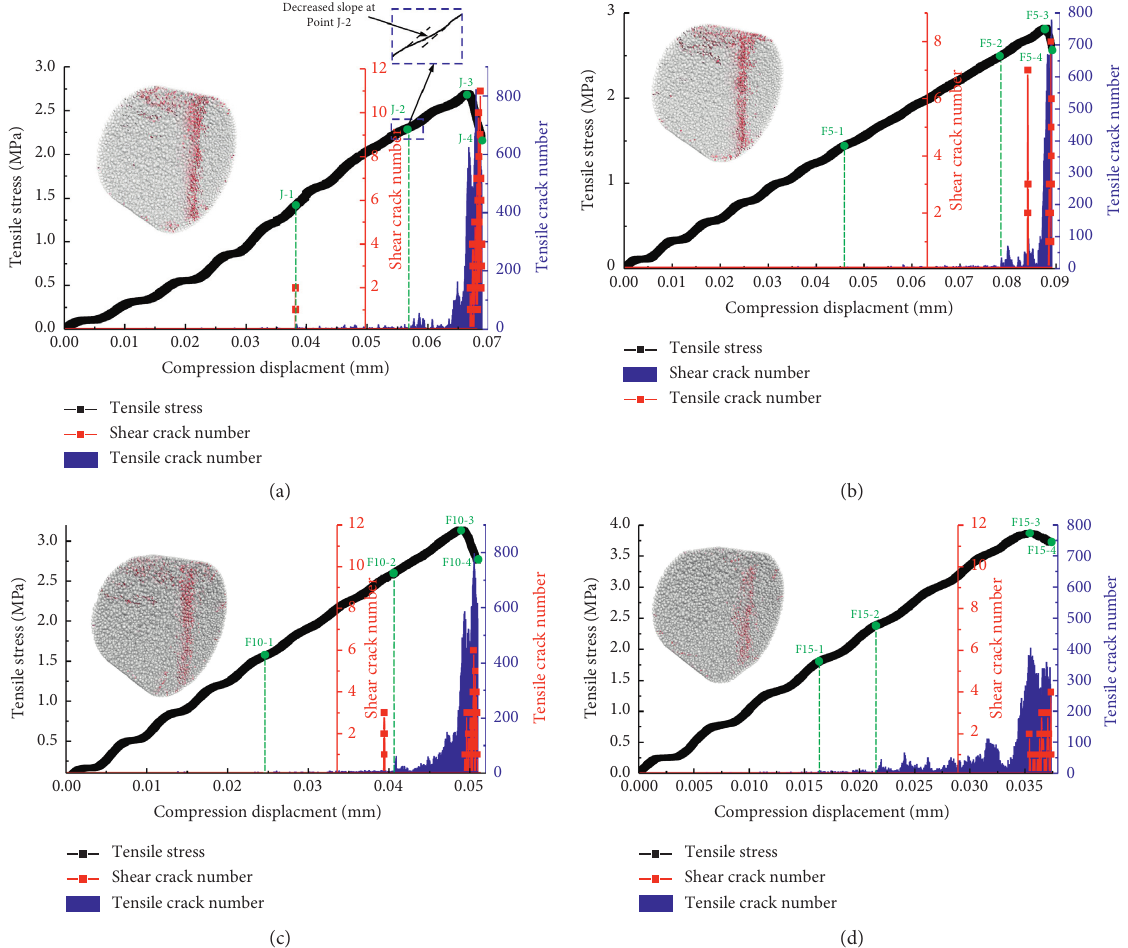
Figure 13: Typical numerical results of the BTand FBTtests: (a) numerical results of the BTtest; (b–d) the FBTtests with the loading angles of 5 ° , 10 ° , and 15 ° ,